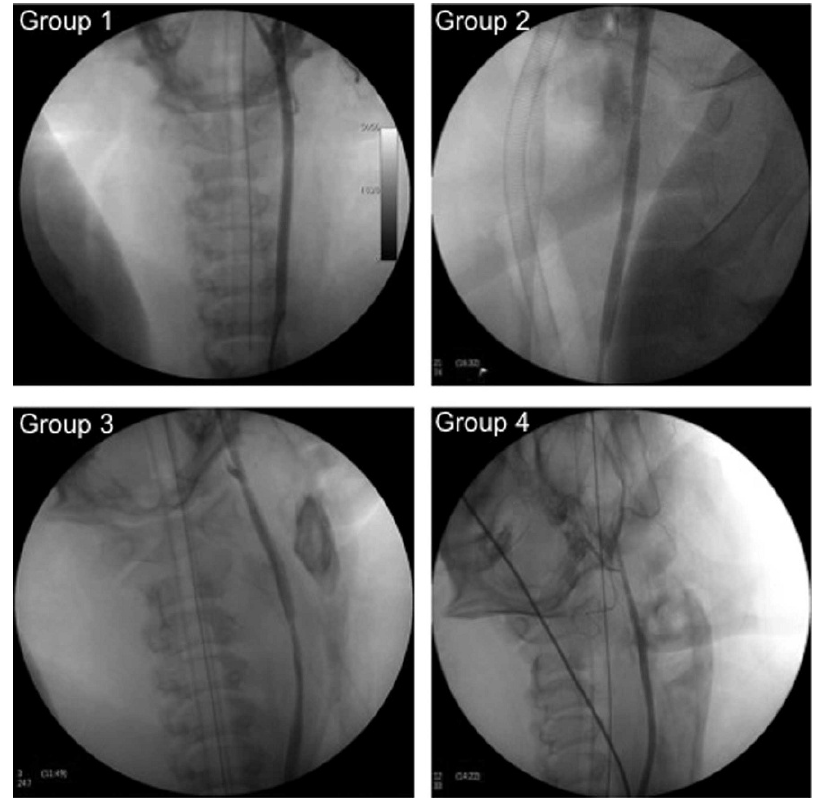
Figure 3 - Control arteriograms showing patency and blood flow in a successful case from each of the four groups.